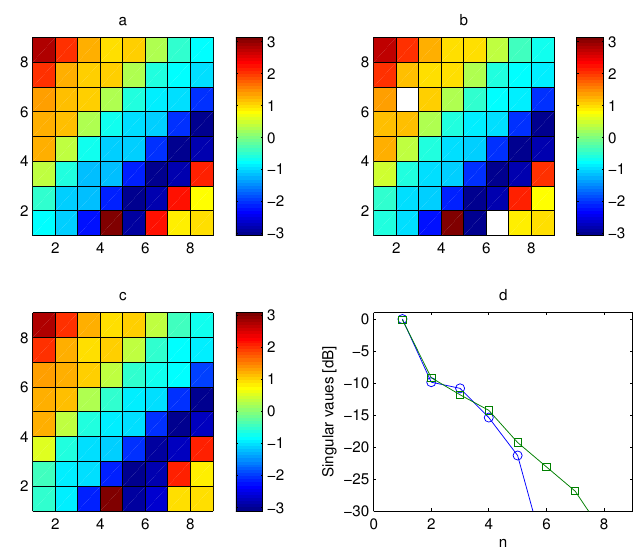
Figure 12. 9 × 9 MIMO system in a corridor, phase of the channel matrix; ( a ) exact (noise-free); ( b ) measured; ( c ) estimated; ( d ) singular value of the exact (circles) and estimated (squares) matrices; the geometry of the problem is shown in Figure 10d.